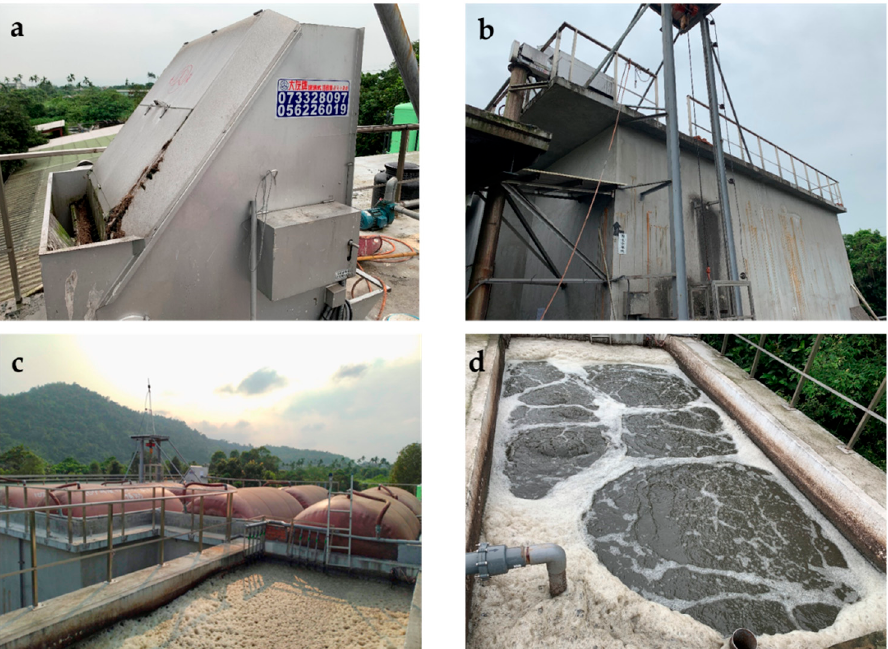
Figure 2. The appearance of the newly designed and constructed piggery wastewater treatment system. From left to right and up to down, they were solid/liquid separator ( a ), wastewater basins ( b ), anaerobic digesters (covered with brick-red plastic cover on the top of the digesters for collecting biogas) ( c ), primary clarifier ( c ), and sequencing batch reactor (SBR) ( d ).